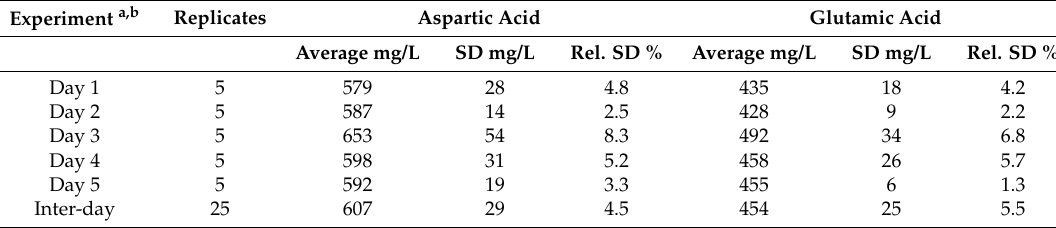
Table 2. Intra- and inter-day repeatability; sample of green, unripe